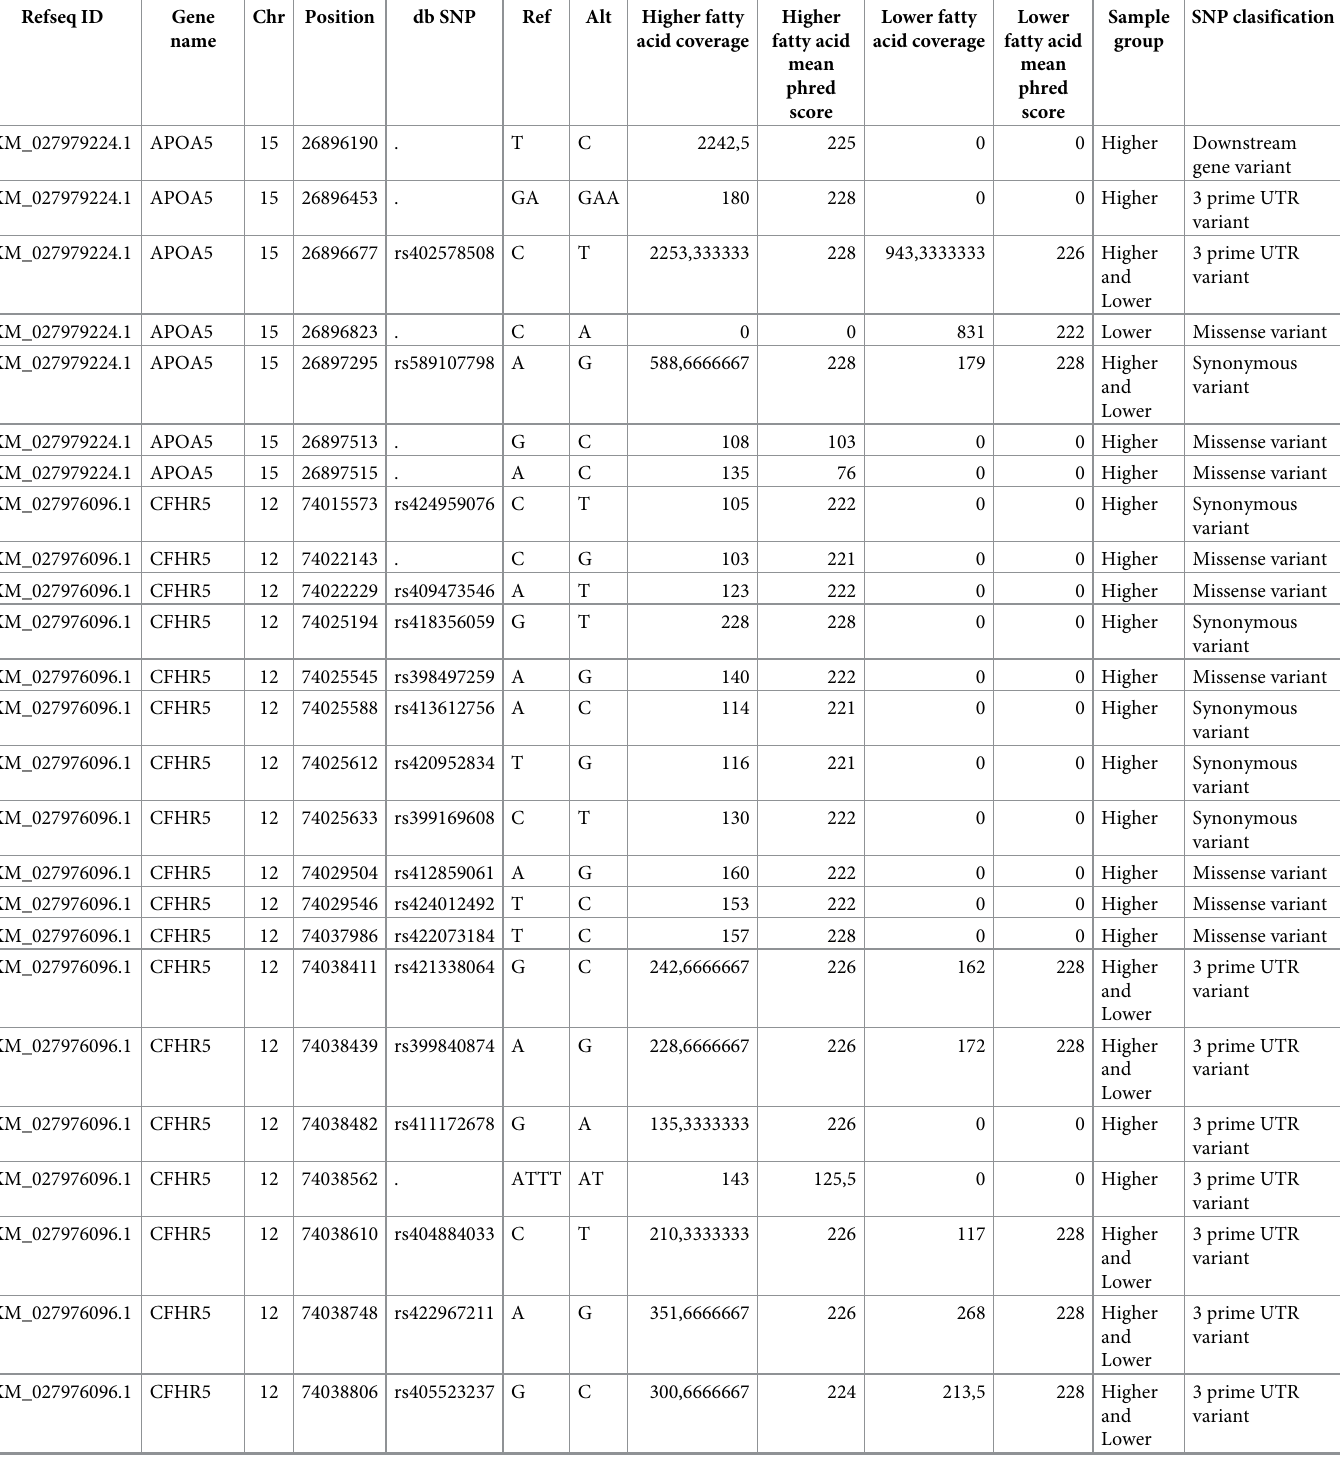
Table 5. Polymorphisms detected in the highly polymorphic